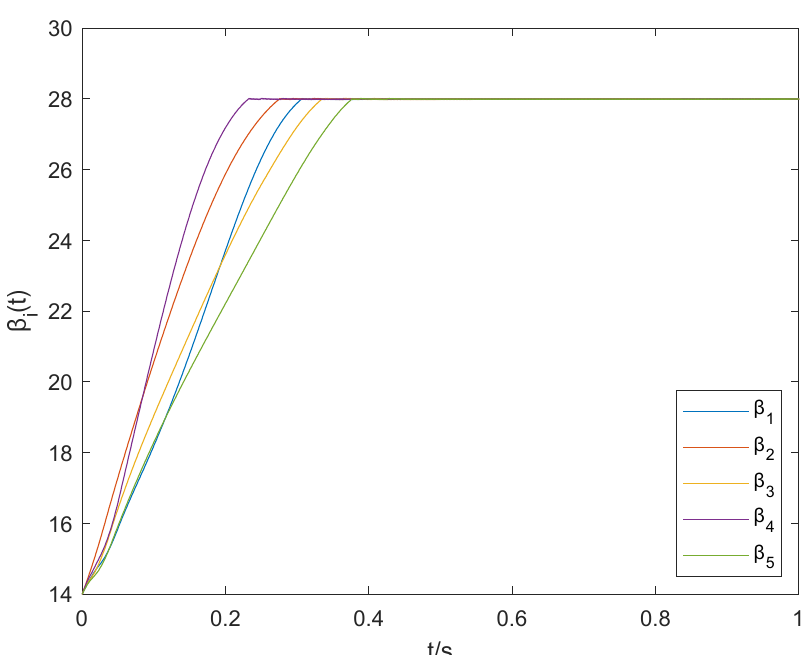
Figure 3. Identification for unknown parameters, α i